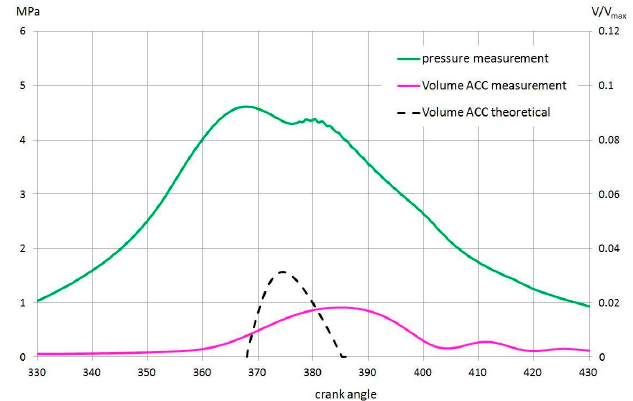
Figure 14. Curve of indicated pressure without volume change in the ACC system, (cr = 17.1: 1, 13 bar) without relative volume in the theoretical complementary system (cr = 17:1).